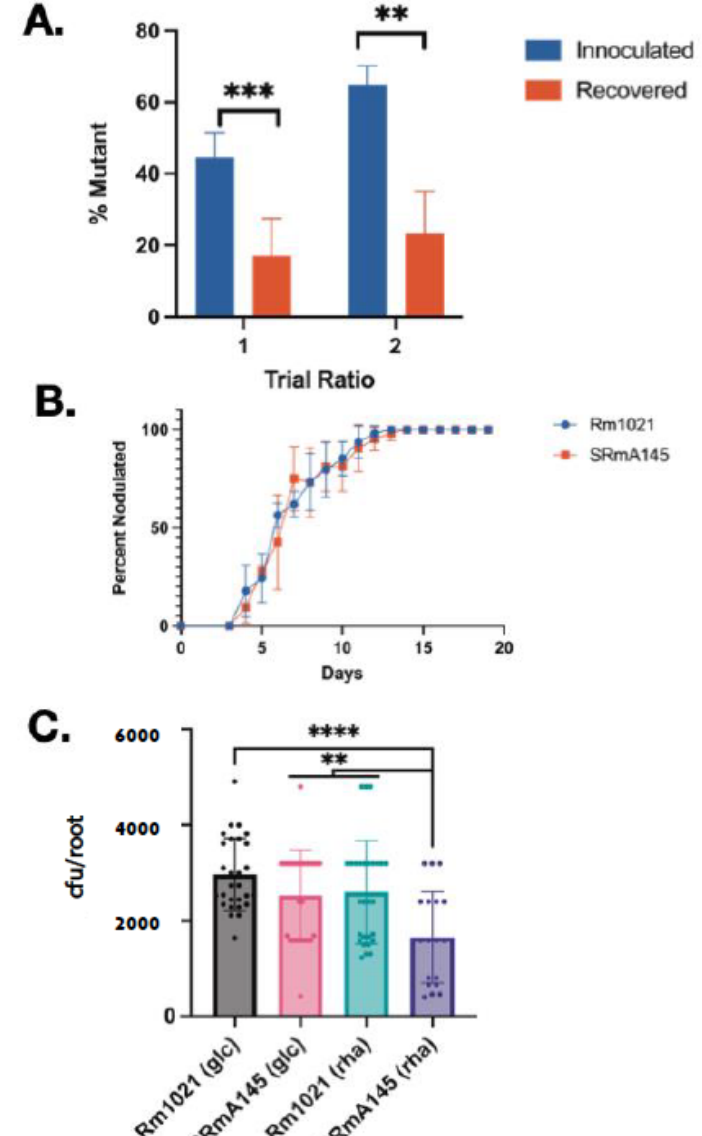
Figure 3. Experimental characterization of plant interaction phenotypes. ( A ) Competition for nodule occupancy assays between Rm1021 (wild-type) and the rhamnose catabolic mutant SRmA145 ( rhaT ::Tn 5 ). SRmA145 was inoculated with the wild-type onto alfalfa plants at two ratios. Blue bars represent the percentage of mutant in the inocula; red bars represent the percentage of nodules occupied by the mutant strain as determined by bacterial isolation from nodules. Ratio 1, n = 6, p < 0.0003; Ratio 2, n = 5, p < 0.009). Significance was determined using an unpaired t -test. ( B ) Nodulation kinetics assays were carried out as described in materials and methods. The data is presented as the mean and error bars represent standard deviation. ( C ) Root attachment assays from single strain inoculations (10 5 cfu/seedling) as described in materials and methods. Solid bars represent the mean. Error bars represent the standard deviation. Individual data points are represented as solid points. Significance was determined using a one way ANOVA and post hoc unpaired t-test. **** p < 0.0001; *** p < 0.001; and ** p < 0.01.